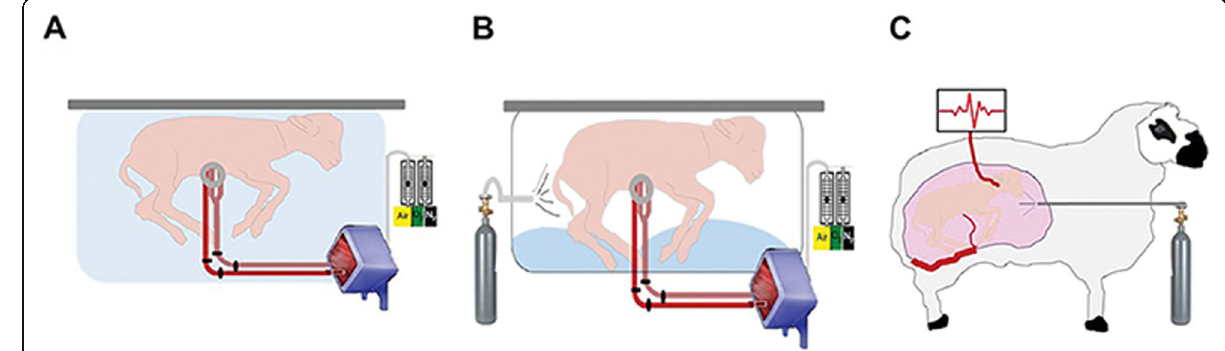
Fig. 1 Experimental conditions. a Fetal sheep (n=6) were cannulated via their umbilical vessels, connected to a low resistance oxygenator circuit and supported in a fluid filled environment. b The fluid filled bag was partially drained and insufflated to 8 mm Hg with carbon dioxide to simulate fetal surgery. c The amniotic cavities of time-dated ewes (n=4) were insufflated with carbon dioxide to simulate fetal